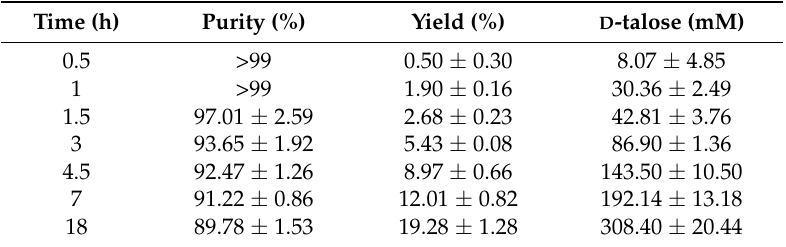
Table 3. Time-course representation of galactose to talose conversion depicting product purity, yield and concentration. Tests were performed at a substrate concentration of 1.6 M and with an enzyme concentration of 0.3 mg/mL. Data represent the means of three experiments with standard deviation. Time (h) Purity (%) Yield (%) D -talose